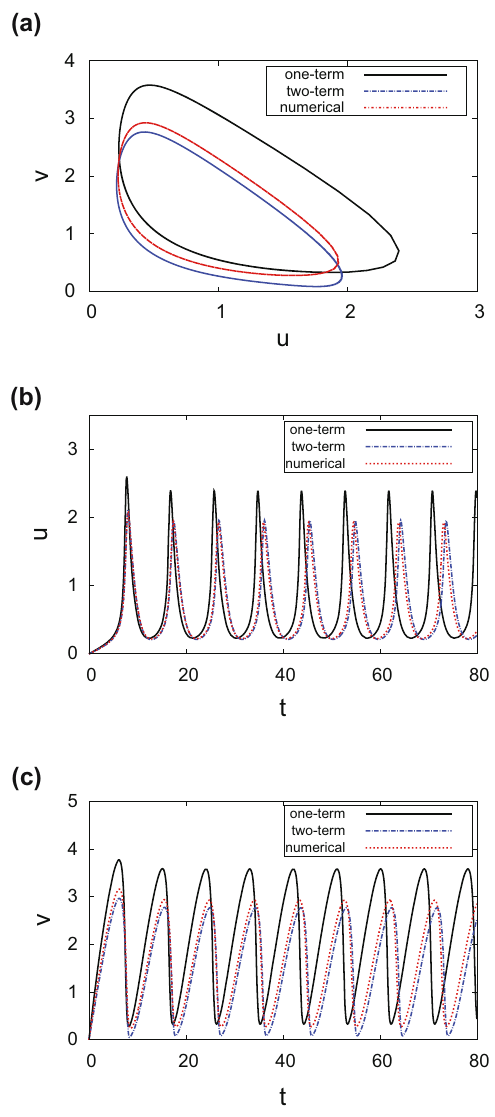
Figure 8: The limit cycle curve within the u against v phase plane ( a ) and the time evolutions for u ( b ) and v ( c ) , respectively, at x 0 = . The parameter space values used are λ 0.06